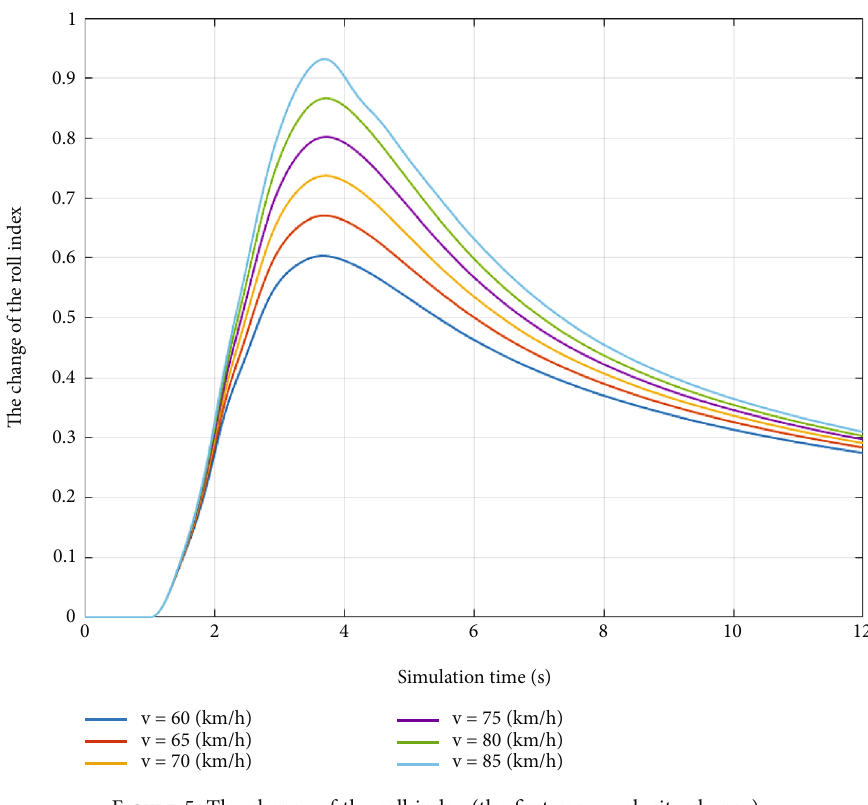
Figure 5: The change of the roll index (the fi rst case — velocity change).